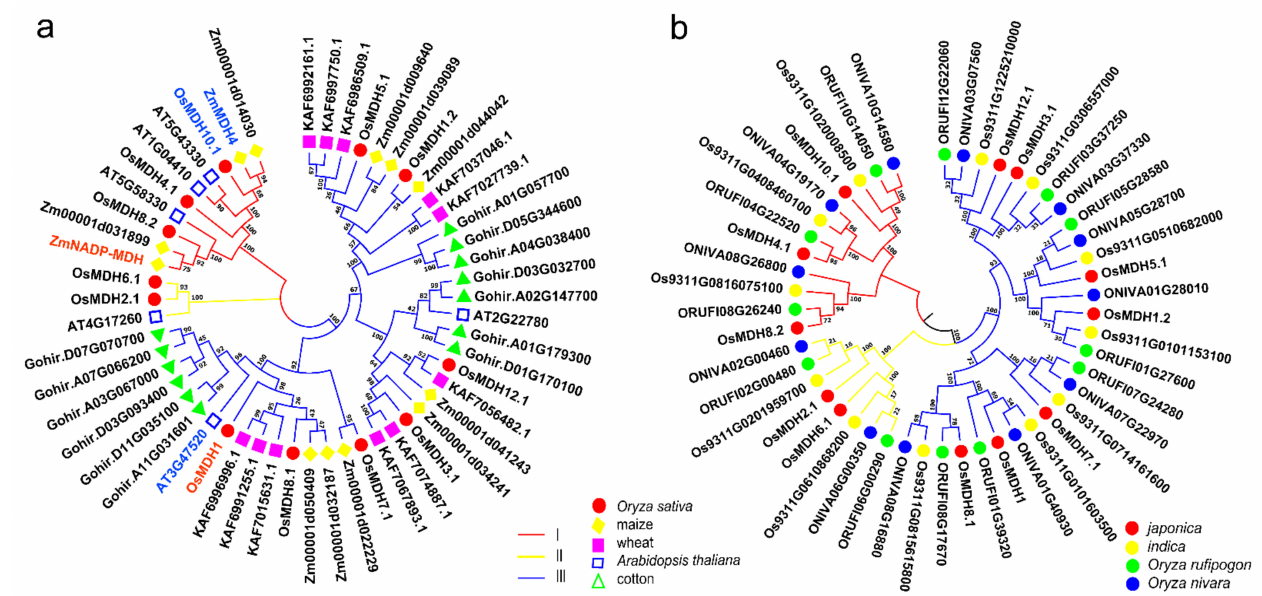
Figure 2. Phylogenetic tree of canonical MDH genes. ( a ) The phylogenetic tree was constructed by comparing the protein sequences of 54 MDH genes from five species, namely rice, maize, wheat, Arabidopsis and cotton. The red, yellow and blue branches represent groups I, II and III, respectively. Genes of rice are marked by red circles; genes of maize are marked by yellow triangles; genes of wheat are marked by pink squares; genes of Arabidopsis are marked by blue boxes; genes of cotton are marked by green triangles. A blue colored name indicates cloned genes associated with seed development, and a red colored name indicates cloned genes associated with salt response. ( b ) The phylogenetic tree was constructed by comparing the protein sequences of 48 MDH genes from japonica , indica , Oryza rufipogon and Oryza nivara . The red, yellow and blue branches represent groups I, II and III, respectively. Genes of japonica are marked by red circles; genes of indica are marked by yellow circles; genes of Oryza rufipogon are marked by green circles; genes of Oryza nivara are marked by blue circles. One thousand repeated boot values are displayed on each node, with the scale indicating the branch